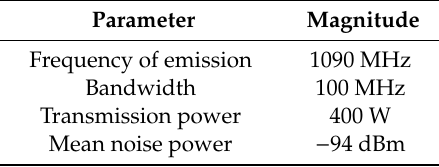
Table 1. Architecture parameters for Cram é r-Rao Lower Bound (CRLB) study. Communication links amongst elements of Asynchronous Time Di ff erence of Arrival (A-TDOA) and Di ff erence-Time Di ff erence of Arrival (D-TDOA) systems are restricted to these principal parameters. They were selected due to their utilization in similar tracking applications in the aerospace industry